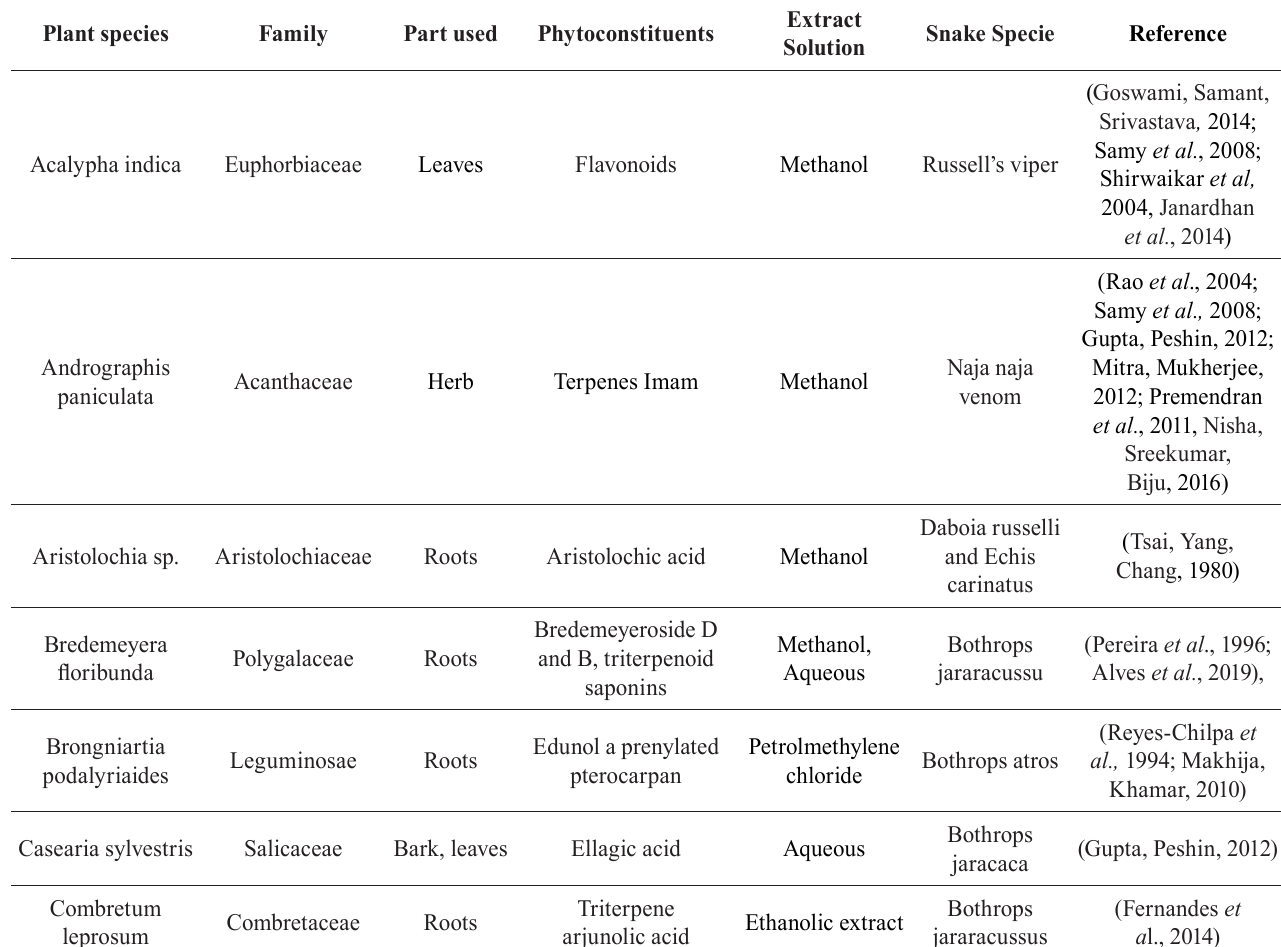
TABLE II - Investigated Medicinal Plans against various Snake Species